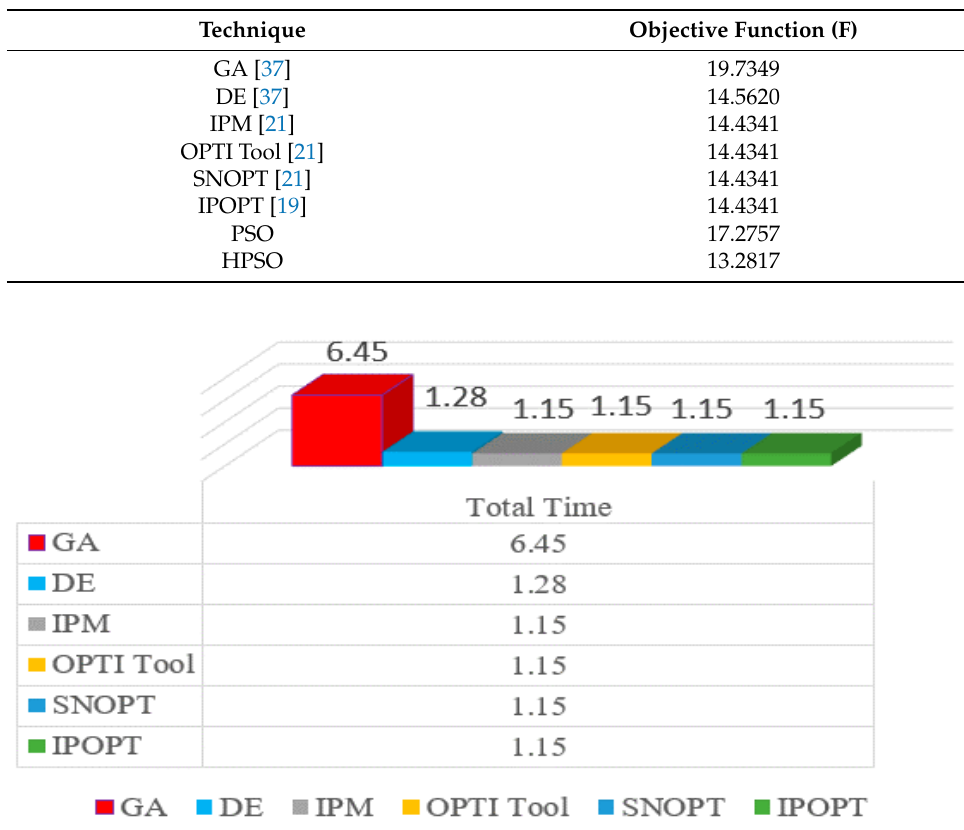
Table 11. Comparison of PSO and HPSO with other techniques.